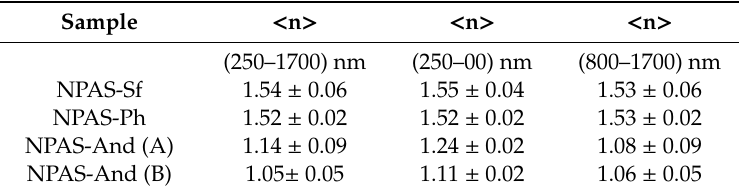
Table 3. Average values of the refraction index determined for the studied samples for the whole range of wavelength as well as for visible and near infrared optical regions.